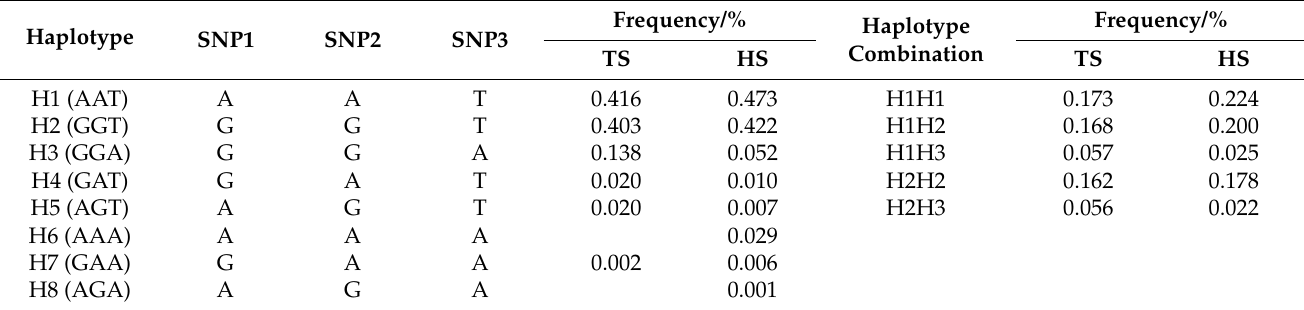
Figure 4. Linkage disequilibrium analysis of three SNPs of HIF-1 α gene. Table 4. Haplotypes and haplotype combinations of three SNPs of HIF-1 α gene. Table 4. Haplotypes and haplotype combinations of three SNPs of HIF-1 α gene.